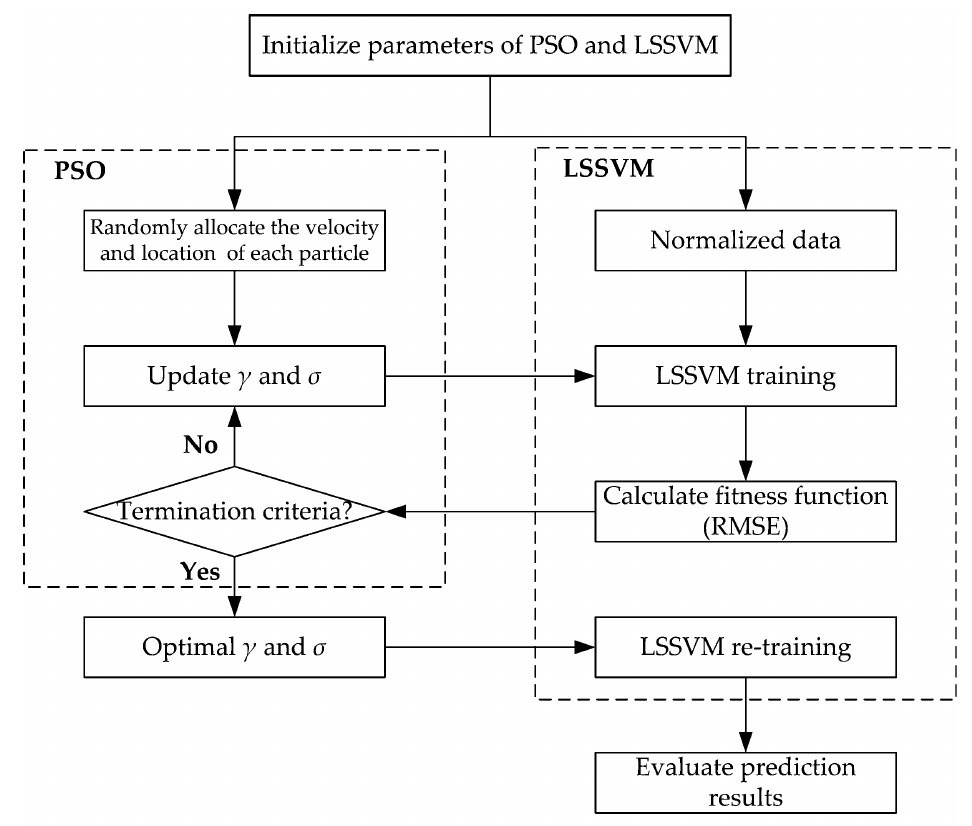
Figure 6. Flowchart of PSO-LSSVM scheme. Figure 4. Flowchart of PSO-LSSVM